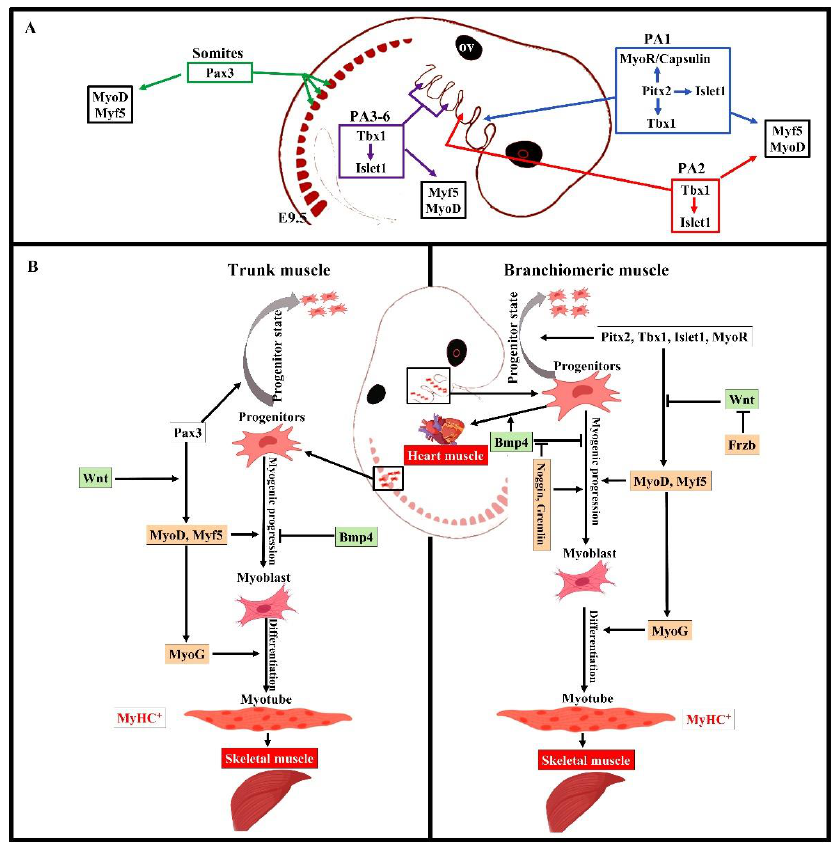
Figure 2. Summary of the distinct genetic program that governs myogenesis in the branchiomeric and trunk muscles. ( A , B ) Model of the genetic networks involved in branchiomeric and trunk muscles. The transcription factors Pitx2, Tbx1, Islet1, and MyoR set up the cardiopharyngeal mesoderm as a skeletal/heart-muscle-competent tissue. Pitx2 is required for the first pharyngeal arch muscle specification by modulating pre-myogenic markers (Tbx1, Capsulin, and MyoR). These genes are required for the activation of myogenic regulatory factors (MyoD and Myf5). The onset of Myf5 and MyoD commits branchiomeric muscle specification. MyoD directly activates genes implicated in keeping myoblasts in a proliferative state, whereas MyoG has antiproliferative activity through the activation of genes that block cell proliferation, promoting cell cycle exit and entry into terminal differentiation [45]. Pitx2 regulates the expression of Islet1, a second heart field marker. Tbx1 is re- quired for the specification of second and caudal pharyngeal muscles. Tbx1 also regulates the ex- pression of Islet1. Initiation of the myogenic program in the trunk and limb is regulated by Pax3, which is not expressed in the cardiopharyngeal mesoderm. BMP4 signals promote cardiogenesis in the head region and block skeletal muscle myogenesis in both the trunk and branchiomeric muscles. Wnt signaling inhibits branchiomeric muscle formation and initiates myogenesis in the trunk re- gion. Antagonists of BMP4 (Noggin and Cremlin) and Wnt (Frzb) signals block cardiogenesis and induce the formation of branchiomeric muscle. PA, pharyngeal arch; ov, otic vesicle. Retrieved from https://app.biorender.com/biorender-templates (accessed on 7 July 2022). 5. The Relationship between Branchiomeric Muscle Progenitors and Neural Crest Cells in Chicken Embryos In vertebrates, the development of musculoskeletal systems requires an interdepend- ent programming event. The morphogenesis of branchiomeric muscles necessitates tight integration with their surrounding connective tissue progenitor cells (cranial neural crest